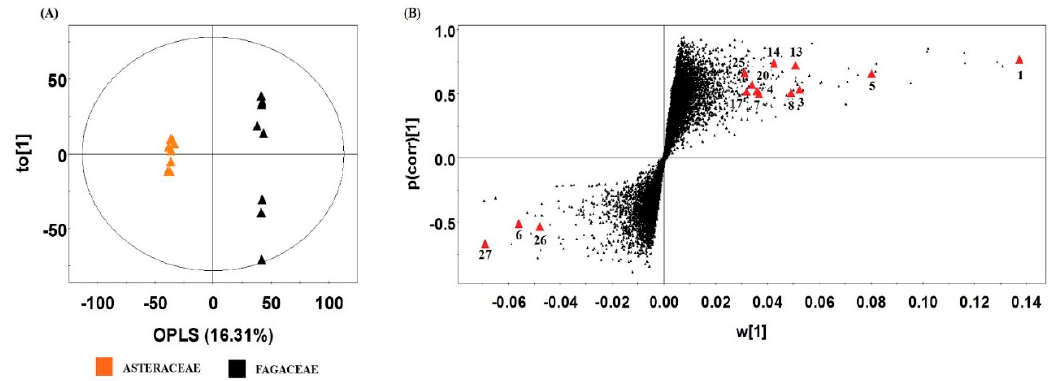
Figure 4. Orthogonal partial least squares discriminant analysis (OPLS-DA) score plot ( A ) and loading S-plot ( B ) derived from the ultrahigh performance liquid chromatography (UHPLC)-linear trap quadrupole-ion trap (LTQ-IT) mass spectrometry/mass spectrometry (MS/MS) dataset for Fagaceae and Asteraceae: R 2 X(0.281), R 2 Y(0.999), and Q 2 (0.854); R 2 X is all the Xs explained by the component, R 2 Y is all the Ys explained by the component, and Q 2 is total variation of the Xs and Ys that can be predicted by the component. The significantly different metabolites ( p -value < 0.05) are highlighted in the S-plot. The numbers indicated on the loading S-plot are based on Table 2.